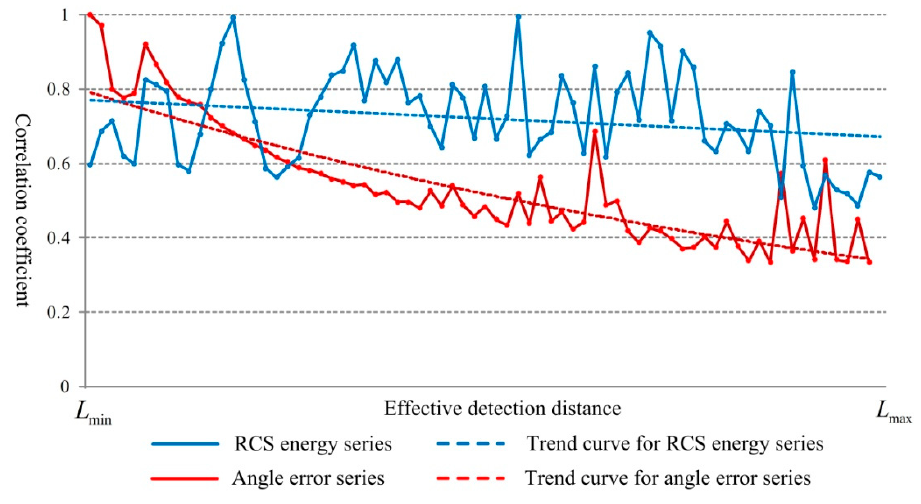
Figure 18. Variations of the correlation coefficients.